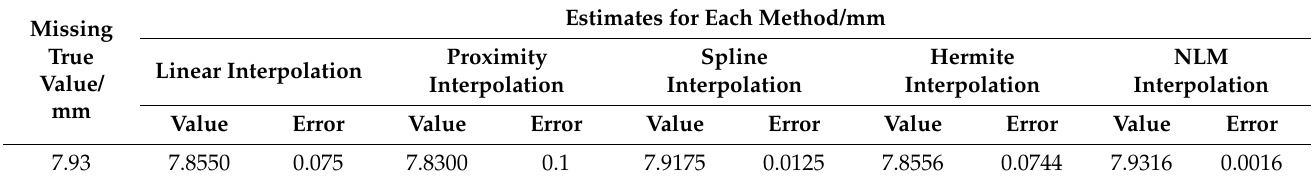
Table 3. Comparison of the estimated results of each interpolation